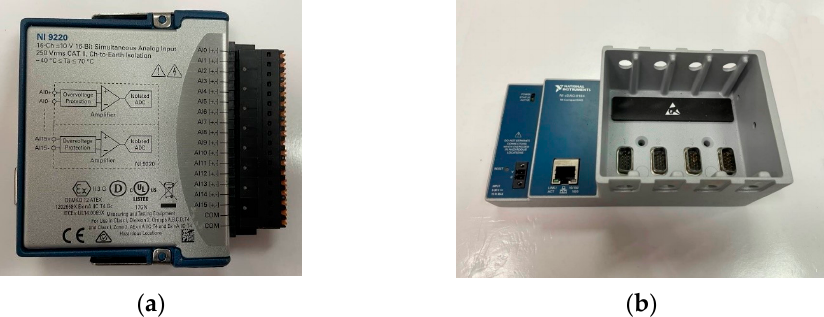
Figure 5. Model structure.